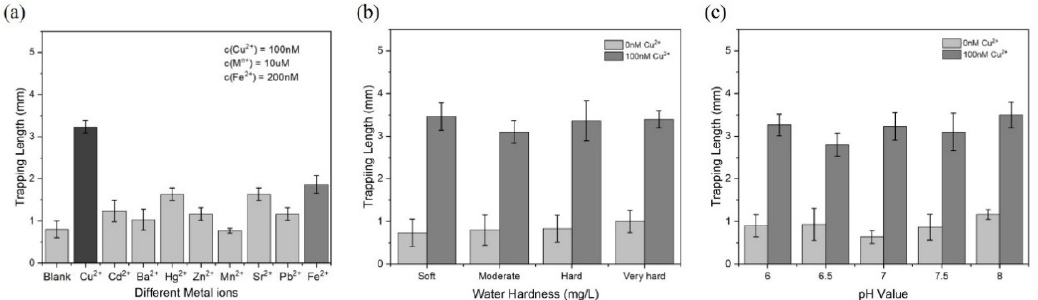
Figure 5. Tolerance of the proposed detection method to environmental interferences. ( a ) Selectivity in the presence of other metal ions (Cd 2+ , Ba 2+ , Hg 2+ , Zn 2+ Mn 2+ , Sr 2+ , Pb 2+ , and Fe 2+ ) with higher concentrations. ( b ). Detection of Cu 2+ in environments with different water hardnesses (soft: 55.0 mg/L; moderately hard: 108 mg/L; hard: 158 mg/L; very hard: 318 mg/L). ( c ) Detection of Cu 2+ in a pH range from 6.0 to 8.0 (mean ± maximumf deviation, n = 3).